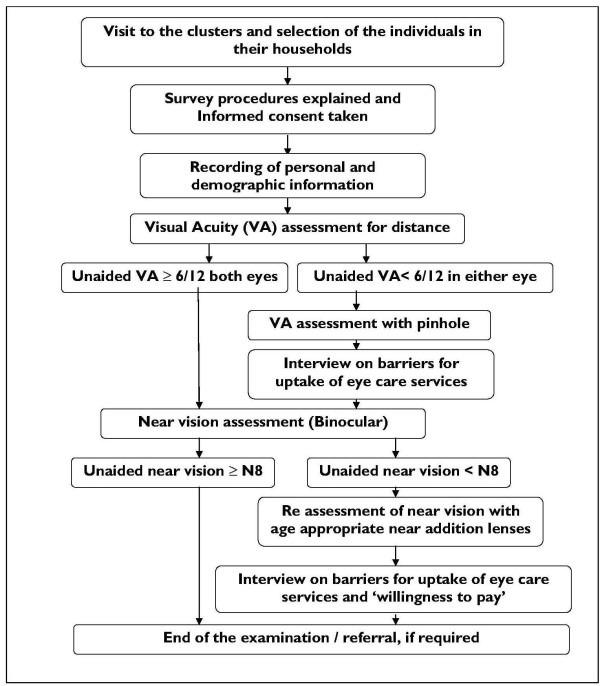
Flowchart showing the sequence of the study procedures.